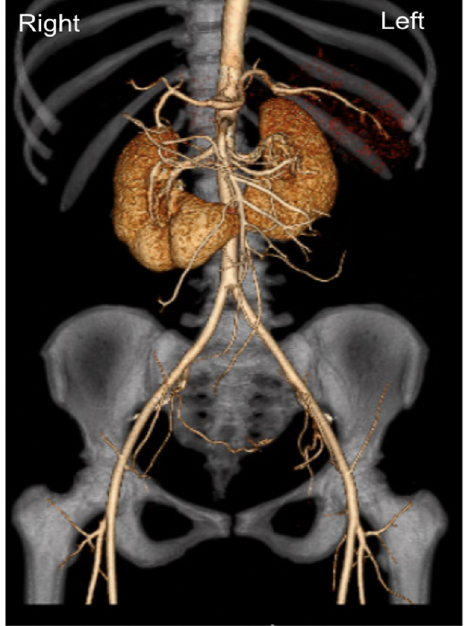
Figure 2. Dynamic CT angiogram with 3D reconstruction showing contiguous renal parenchyma crossing the midline between the aorta and the inferior mesenteric artery; single right and left renal arteries.